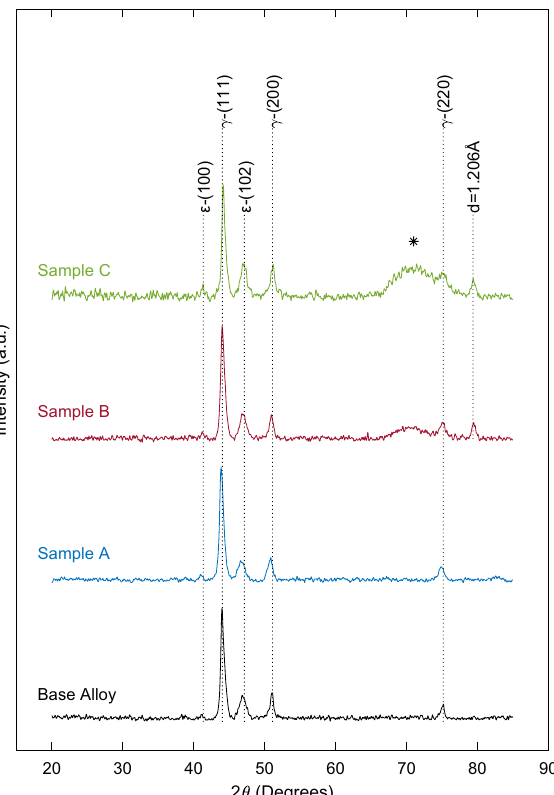
Figure 5. XRD analysis of test samples. Base Alloy, representing an untested sample, displays a diffraction pattern with peaks at 2θ equal to 41.3°, 44.1°, 47.1°, 51.0°, and 75.1°. Sample A, shielded from electrical activity, displays a diffraction pattern with peaks at 2θ equal to 41.3°, 44.1°, 47.1°, 51.0°, and 75.1°. Sample B, subjected to 50 MHz 200 mVpp sine wave, displays a diffraction pattern with peaks at 2θ equal to 41.3°, 44.1°, 47.1°, 51.0°, 75.1°, 79.3°, and a broad peak between ~ 69°–71°. Sample C, subjected to 100 MHz 200 mVpp square wave, displays a diffraction pattern with peaks at 2θ equal to 41.3°, 44.1°, 47.1°, 51.0°, 75.1°, 79.3°, and a large, broad peak between ~